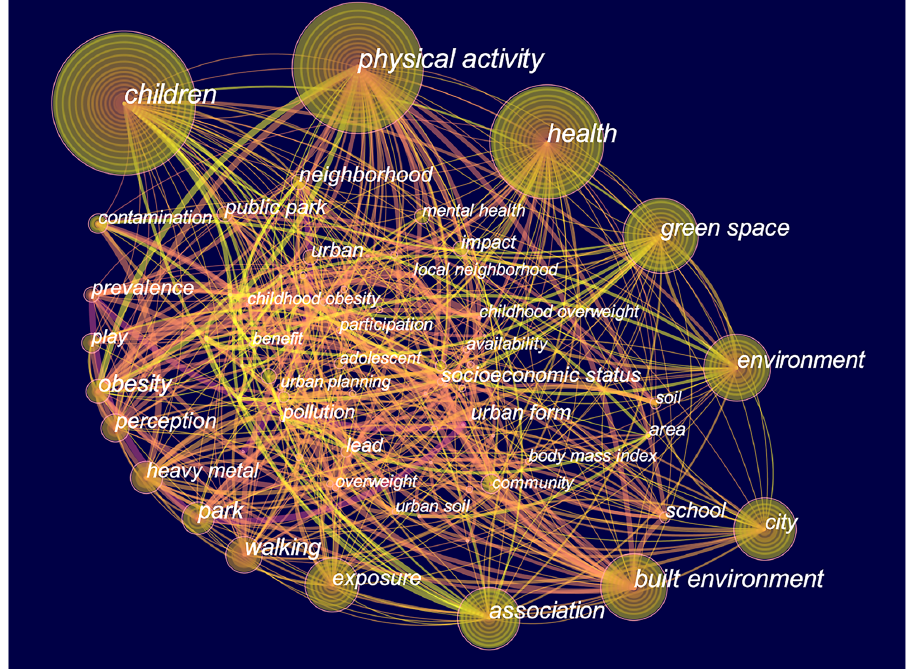
Figure 9. Keyword co-occurrence network. Table 3. Top 30 most frequently used keywords during 1980–2022. No.